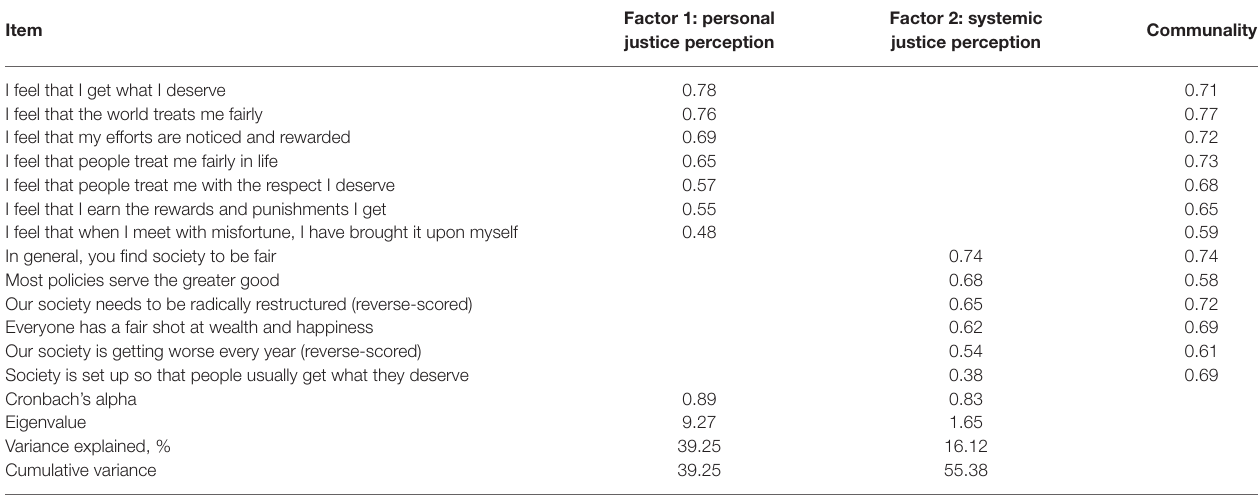
TABLE 1 | Exploratory factor analysis of the scales for measuring justice perception ( N =